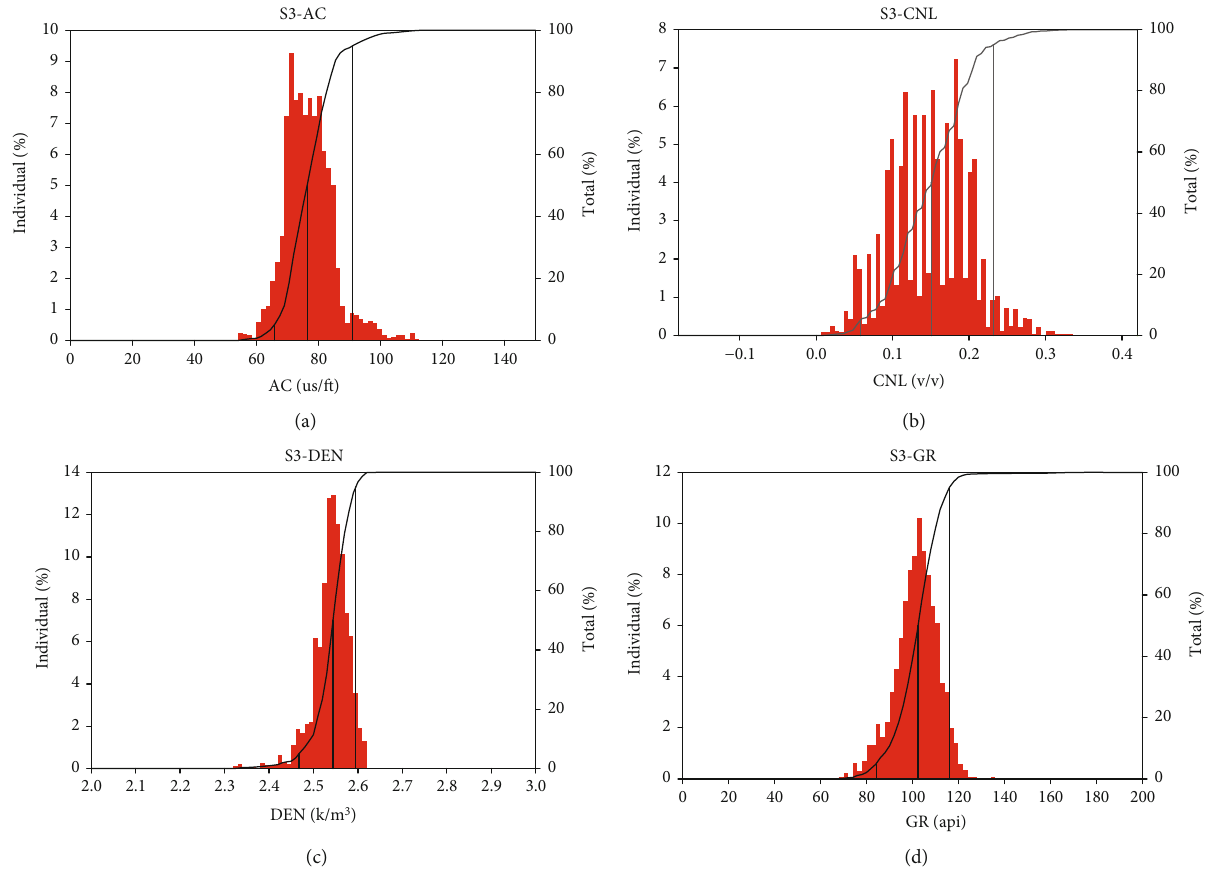
Figure 15: Frequency distribution histogram of AC, CNL, DEN, and GR of S